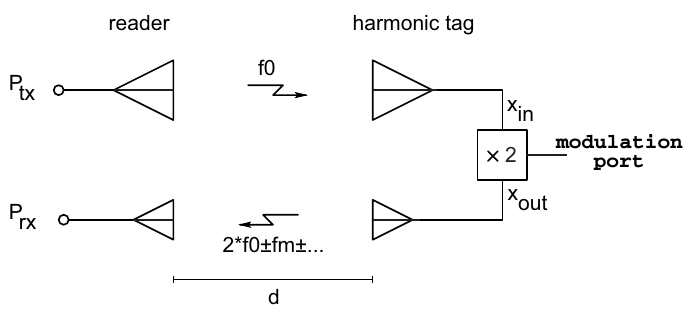
Figure 1. Block diagram of the proposed system, based on a modulation-capable Schottky-diode frequency doubler.